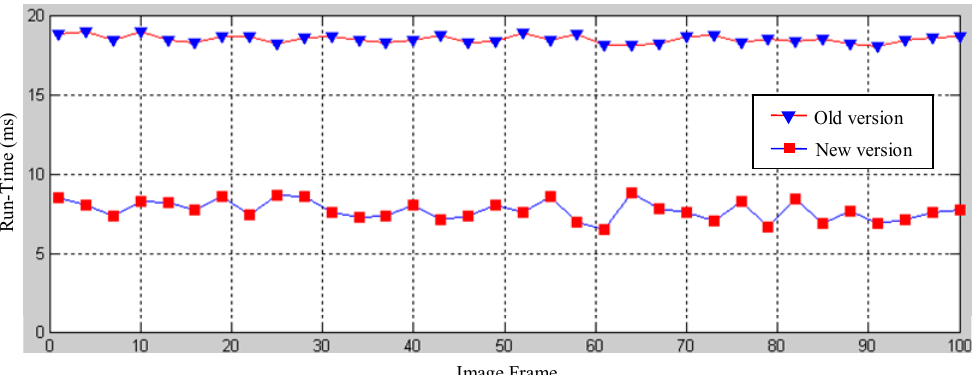
Figure 25. Run-time improvement of object profile separation in the near-field model.